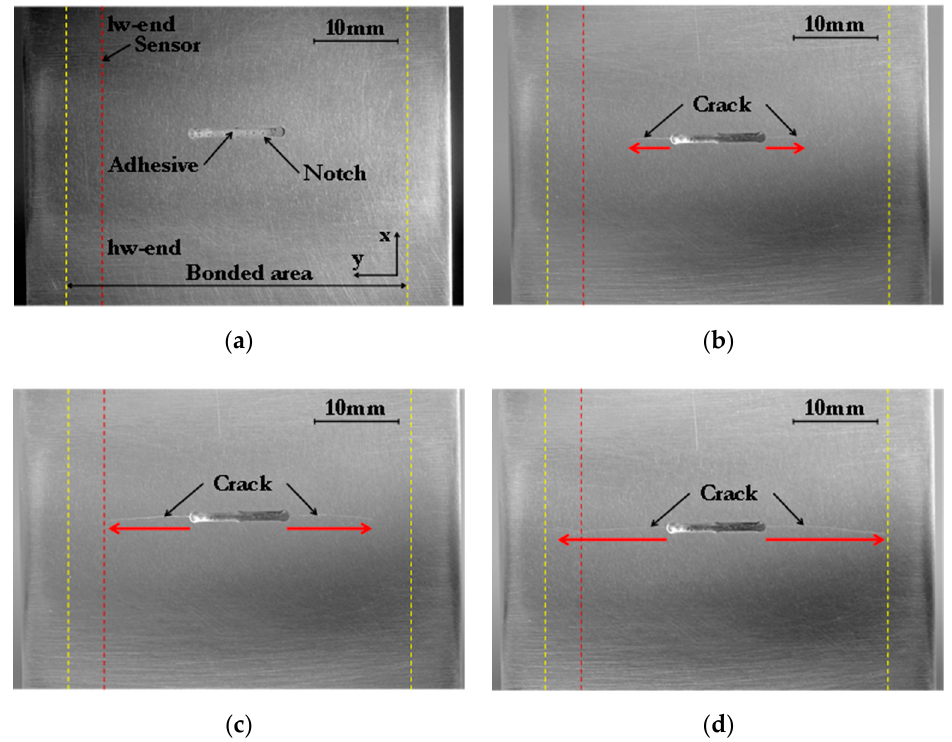
Figure 3. Photographs of the unpatched face of the repaired coupon after ( a ) 0, ( b ) 86,000, ( c ) 101,000, and ( d ) 106,000 fatigue cycles showing the approximate location of the sensor (red dashed line) and patch boundaries (yellow dashed lines).